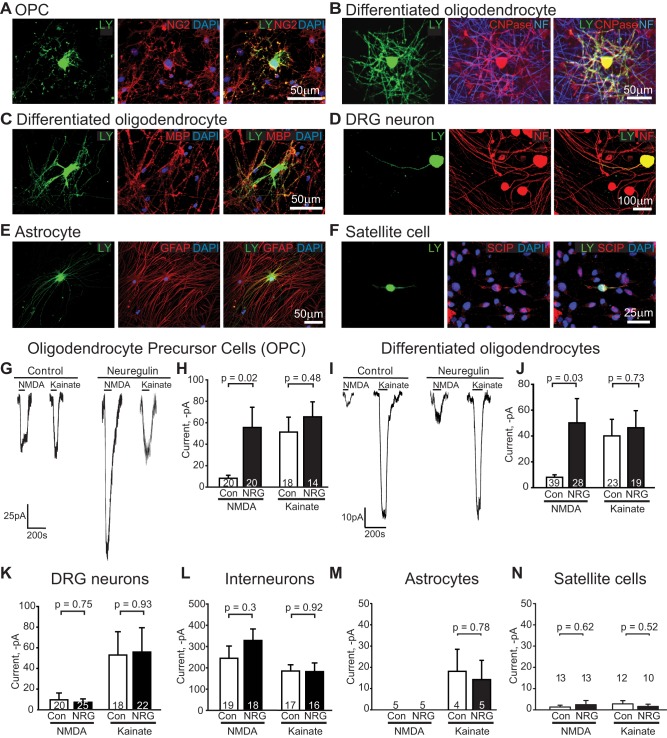
NRG specifically increases NMDA receptor currents in oligodendrocyte lineage cells.(A–F) Images of Lucifer yellow in patch-clamped cells (left), antibody labelling for identification (middle), and merged images (right). (A) NG2-expressing OPC. (B) CNPase-expressing myelinating oligodendrocyte, with axons labelled for NF 160/200. (C) Myelinating oligodendrocyte expressing MBP. (D) NF 160/200-expressing DRG neuron. (E) GFAP-expressing astrocyte. (F) SCIP-expressing satellite cell. (G–J) Specimen currents and mean currents (number of cells shown on bars) evoked at −64 mV by 60 µM NMDA and 30 µM kainate in the absence or presence of NRG, in (G–H) oligodendrocyte precursor cells and (I–J) differentiated oligodendrocytes in the process of myelinating neurons. (K–N) Mean currents in (K) DRG neurons, (L) interneurons, (M) astrocytes, and (N) satellite cells. Internal solution had ECl = 0 mV. See also Figure S4.